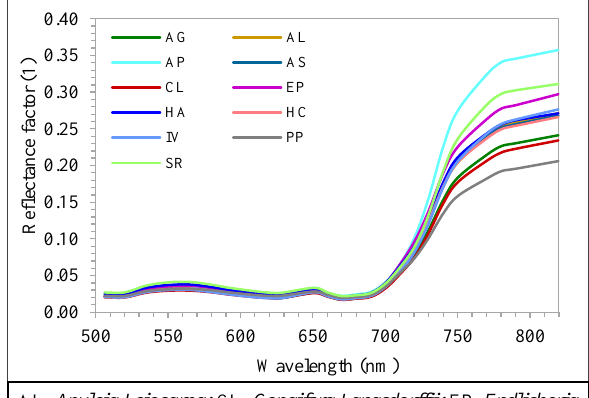
Figure 1. Mean spectra for each tree recognized in field. Mean spectra extracted from the hyperspectral